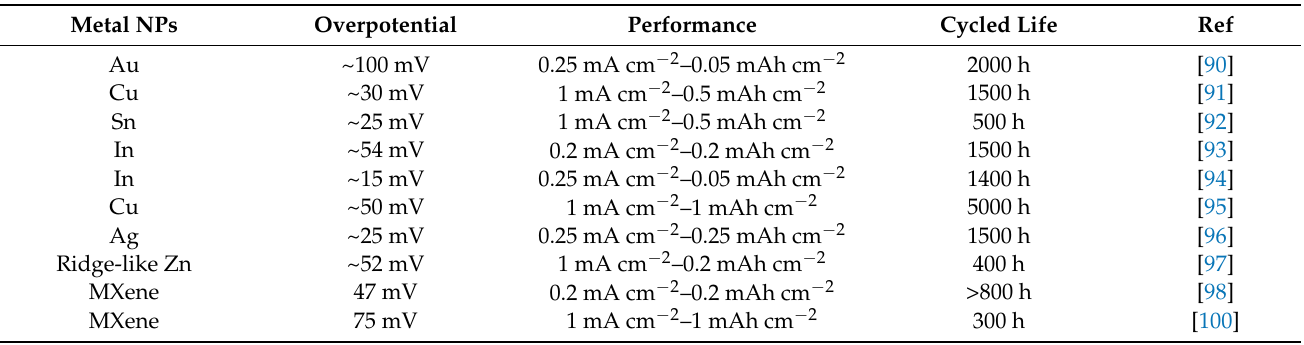
Table 2. Summary of metal nanoparticles (NP) and MXene as coating materials for improving Zn metal